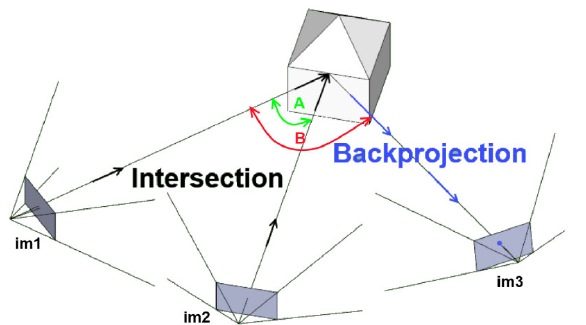
Figure 1. Intersection of 2 rays deliver a 3D point. This point can be re-projected onto another image (by a known